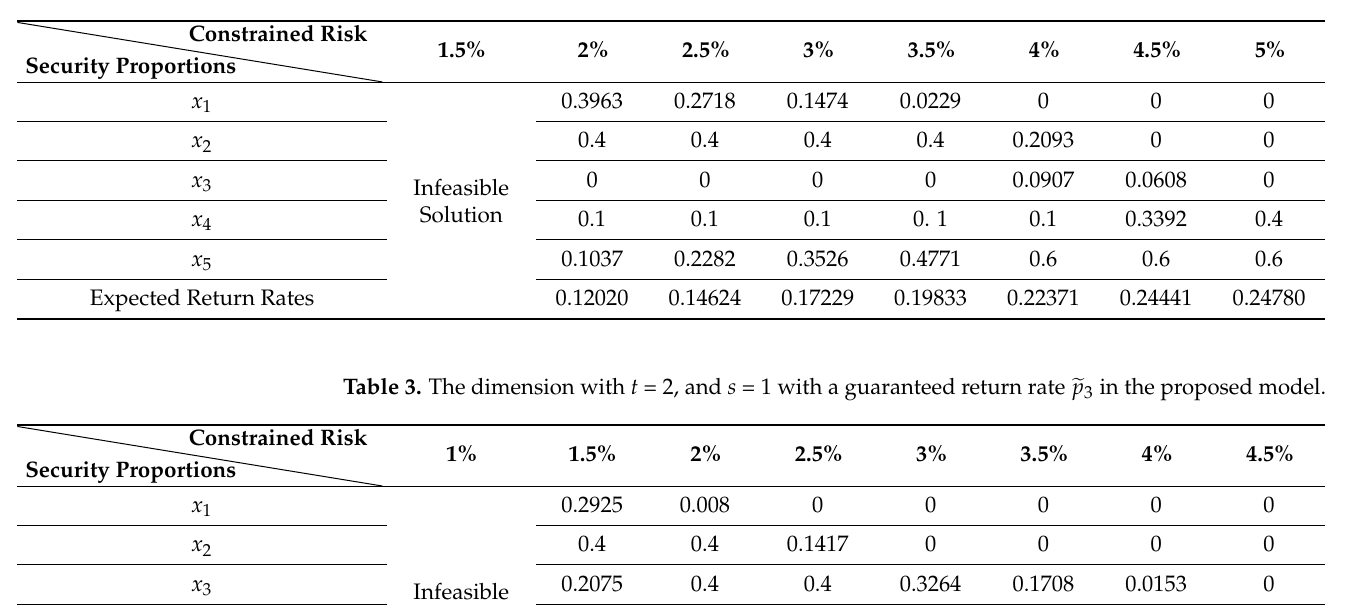
Table 2. The dimension with t = 2, and s = 1 with a guaranteed return rate (cid:101) p 2 in the proposed model.